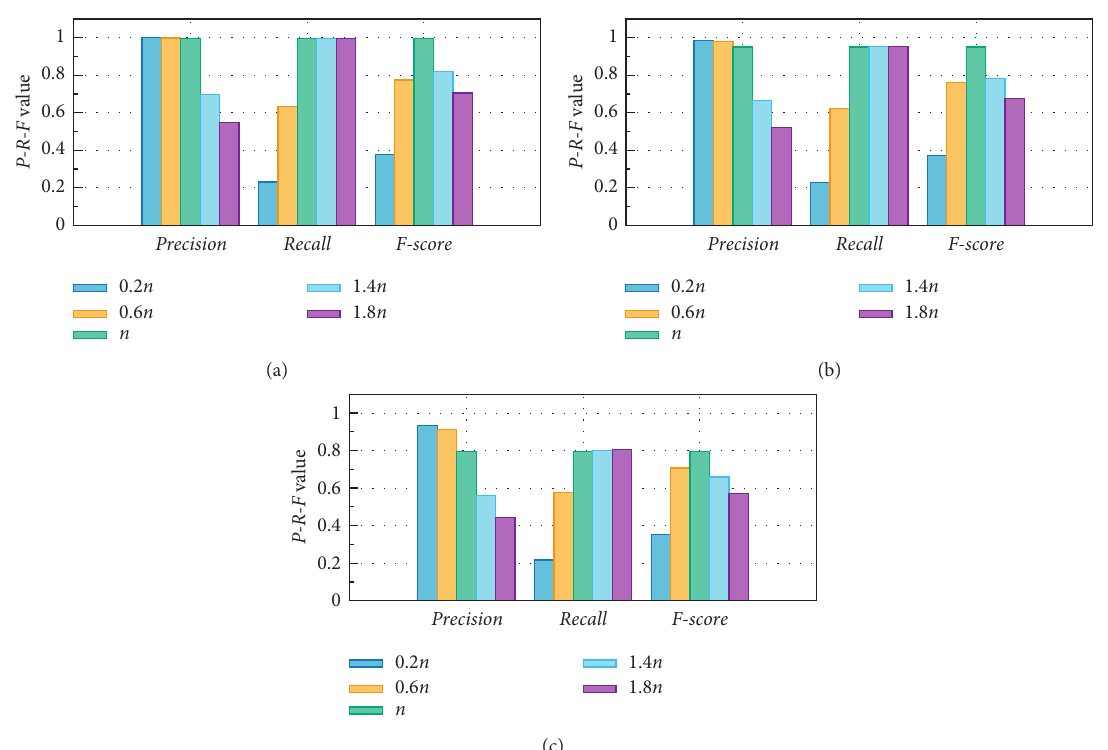
Figure 9: Experimental results of varying parameter k . (a) Experimental result with different k (0.2 n ∼ 1.8 n ) on LFR5K ( μ � 0 . 2). (b) Experimental result with different k (0.2 n ∼ 1.8 n ) on LFR5K ( μ � 0 . 35). (c) Experimental result with different k (0.2 n ∼ 1.8 n ) on LFR5K ( μ � 0 .